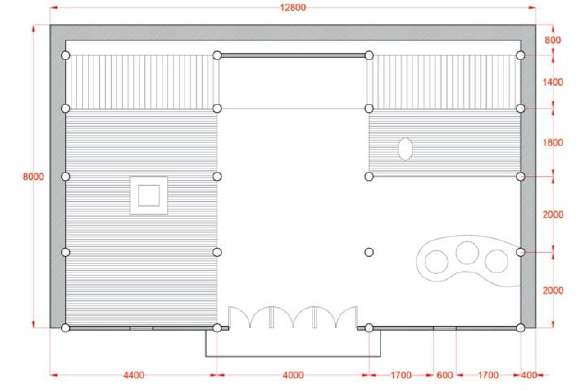
Figure 13. The Layout of I-shaped houses.